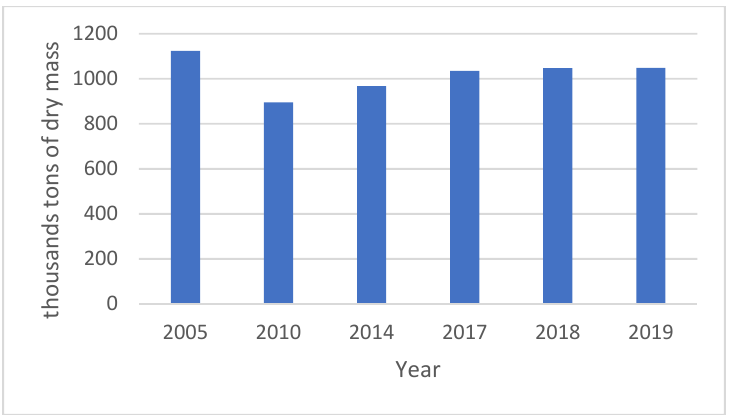
Figure 1. Amount (thousands of tons of dry mass) of sludge generated in Poland (municipal and industrial WWTPs) in the years 2005, 2010, 2014, 2017, 2018 and 2019 [3]. The problem with the presence of parasite eggs in sewage sludge is still